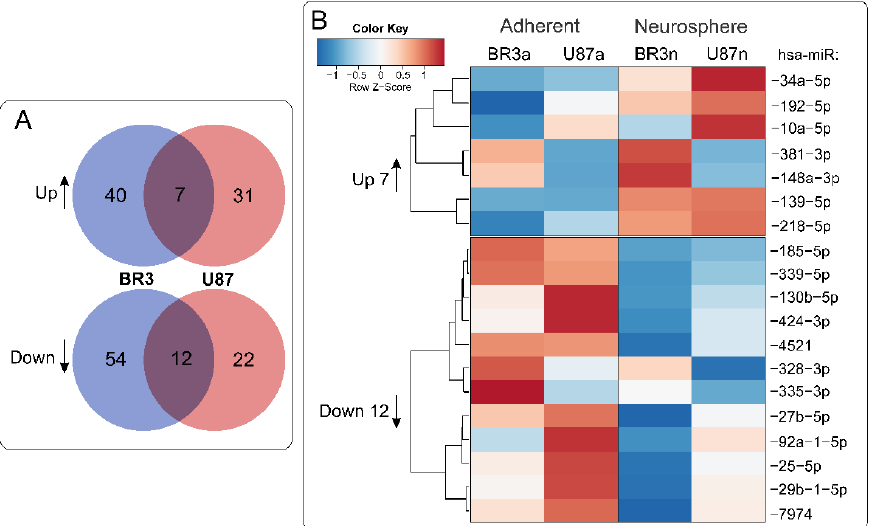
Figure 3. ( A ) Venn diagrams showing intersections of miRNA sets of BR3 and U87 GBM cultures, separately for miRNAs with increased (Up) or decreased (Down) levels of NS compared to the corresponding adherent cultures. ( B ) Heatmap of 7 commonly upregulated and 12 commonly downregulated miRNAs in NS vs. MN GBM